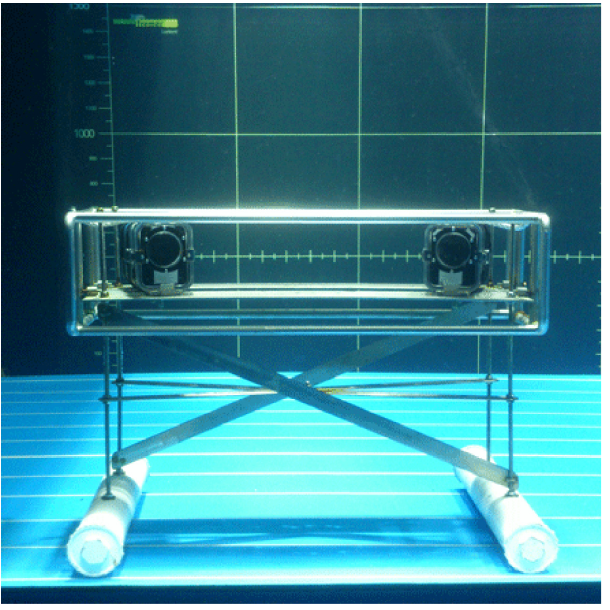
Fig 2. The observation unit in the IFREMER Lorient flume tank.